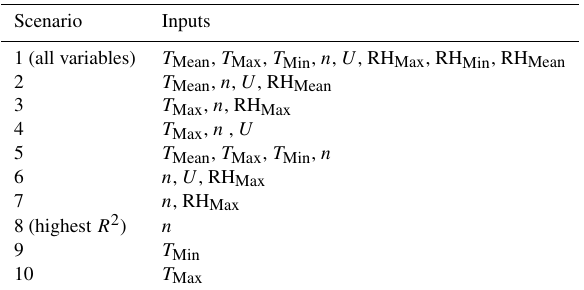
Table 2. The scenarios developed in this study with respective in- puts in respective